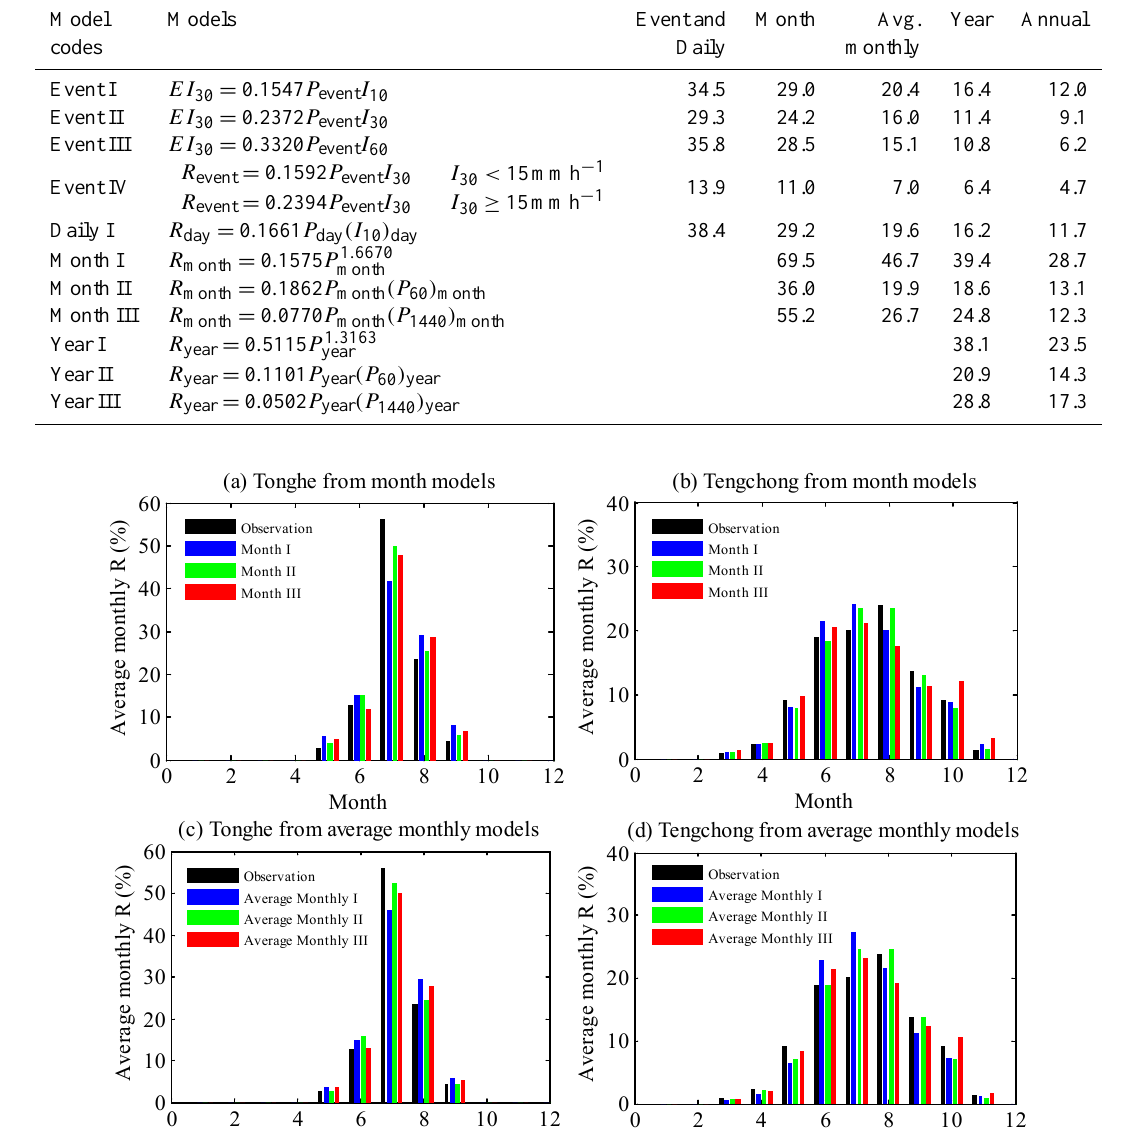
Table 6. MAPE sym for the models when used to estimate longer timescales of erosivity.